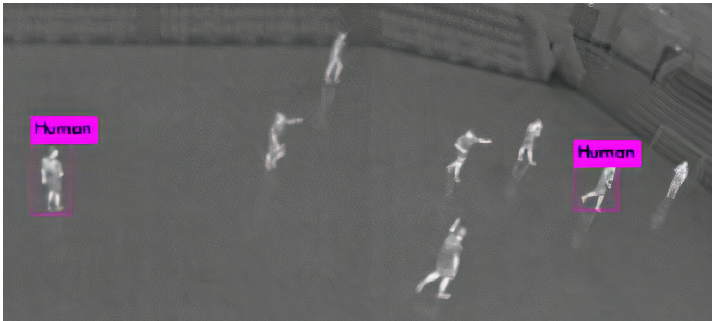
Figure 17. Failure case of the method proposed by Mate et al. [54]. Fails at detecting persons from the bird’s-eye view. Reprinted from [54].